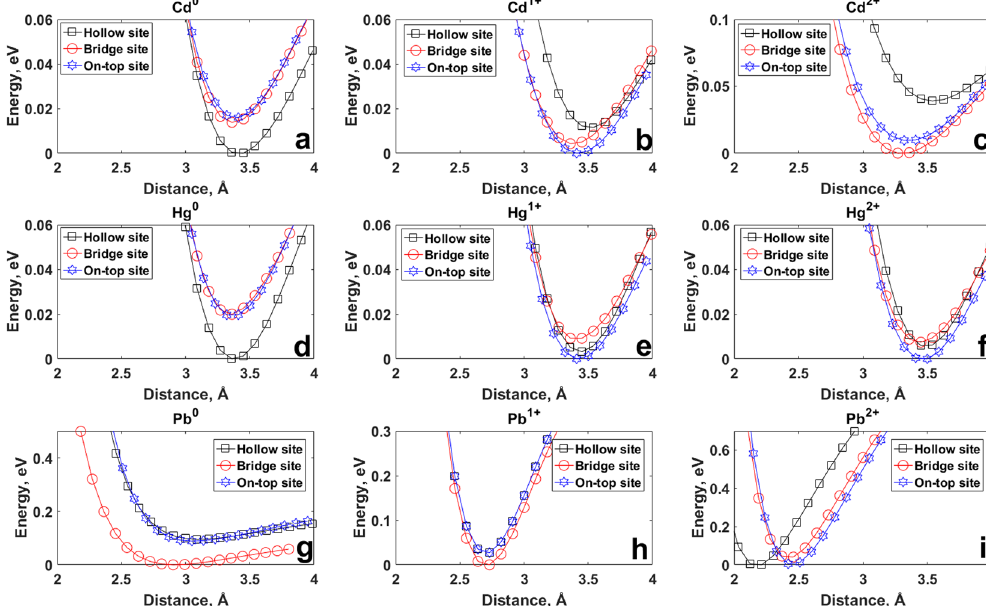
Figure 2. Potential energy curves for neutral atoms: ( a ) Cd°, ( d ) Hg° and ( g ) Pb°; for monovalent ions: ( b ) Cd 1 + , ( e ) Hg 1 + and ( h ) Pb; 1 + and for divalent ions: ( c ) Cd 2 + , ( f ) Hg 2 + and ( i ) Pb 2 + on C 54 H 18 quantum dots (top- site position, hollow site position, bridge site position). The energy is given relative to the largest negative value of the total energy of the system over the entire scanning range.